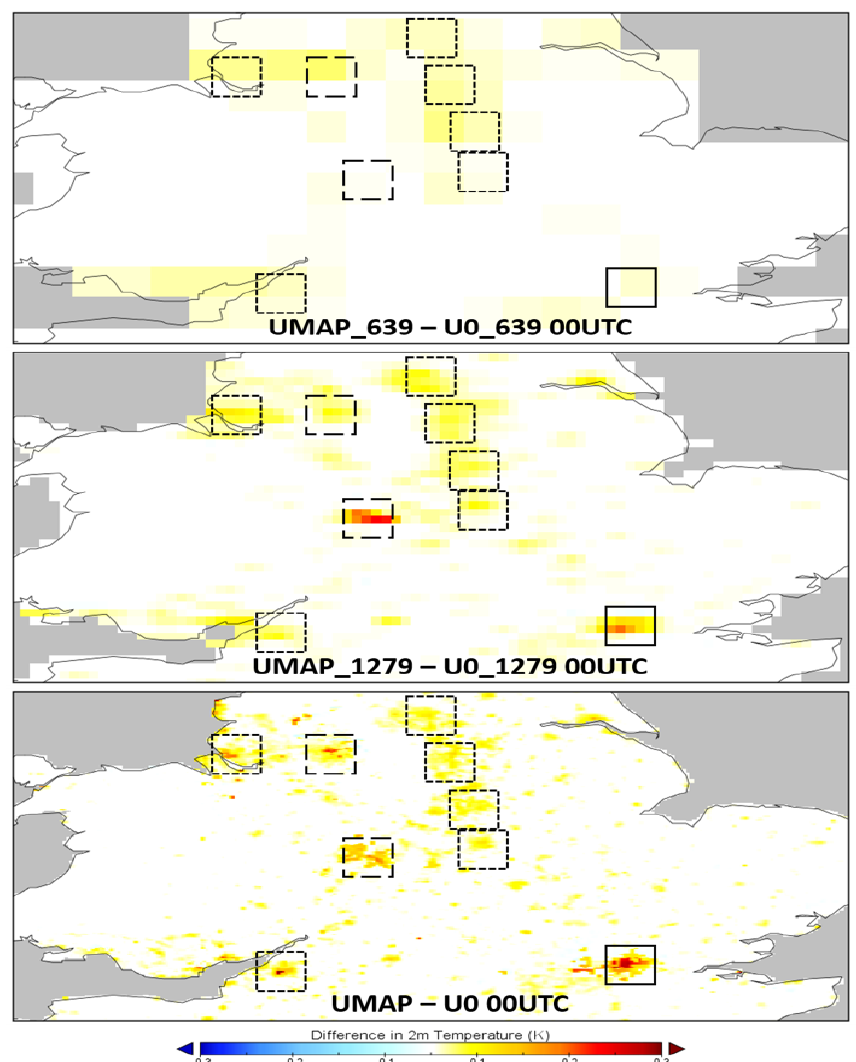
Figure 26. The difference between urban and control monthly mean 2 m temperature over central UK for 00:00 UTC January 2019 at 30 km ( top ), 9 km ( middle ) and 1 km horizontal resolution ( bottom ) taken from ECLand simulations. Conurbations larger than 1000 km 2 (solid), 500 km 2 (dashed) and 100 km 2 (dotted) are denoted with boxes (adapted from